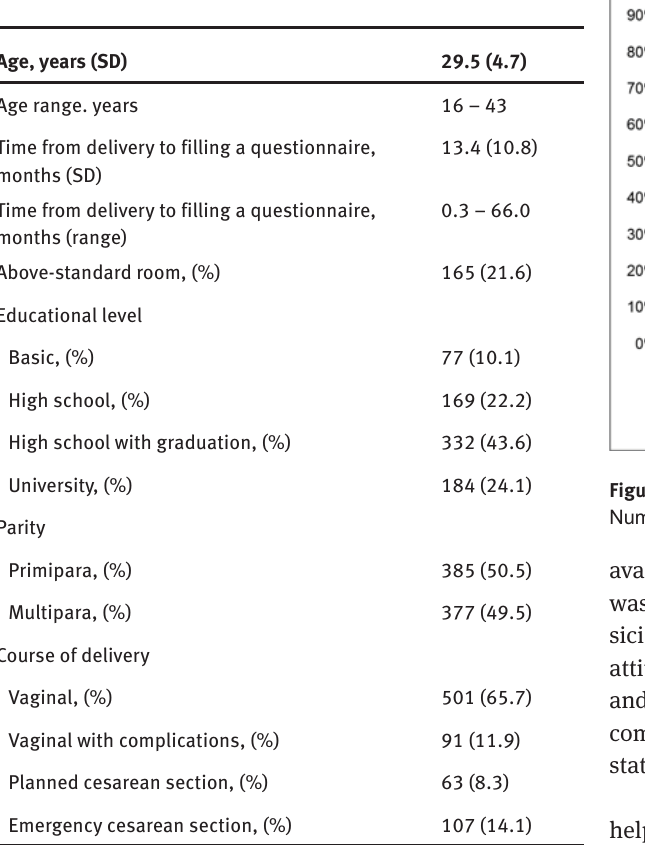
Table 1 : Socio-demographic and obstetric characteristics (N = 762)